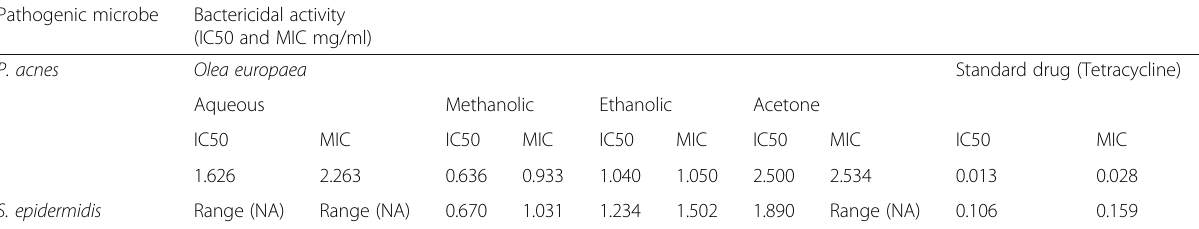
Table 1 Antibacterial activity of Olea europaea leaf extracts of different solvent along with standard against P. acnes and S. epidermidis Pathogenic microbe